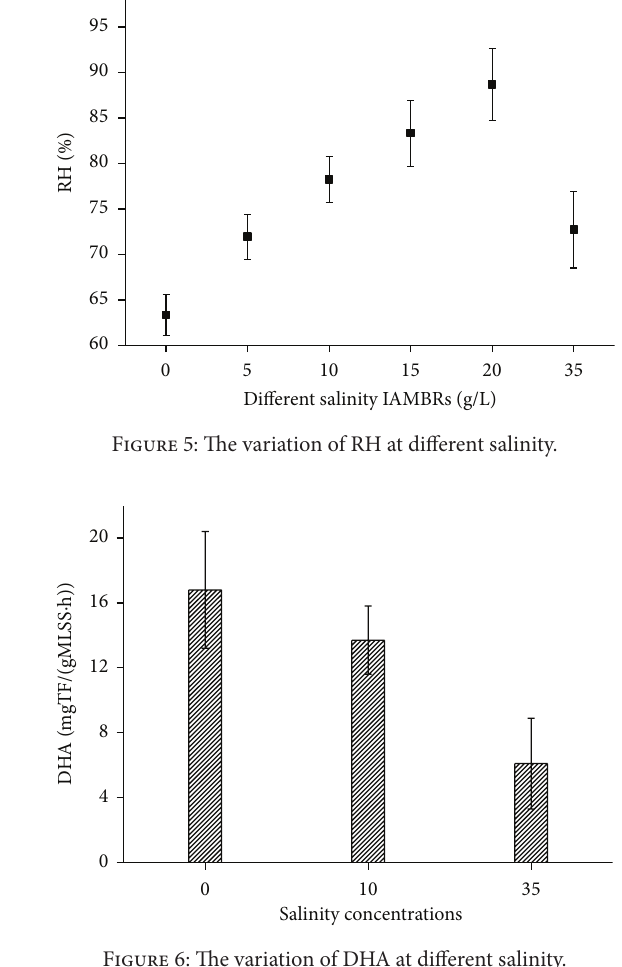
Figure 6: The variation of DHA at different